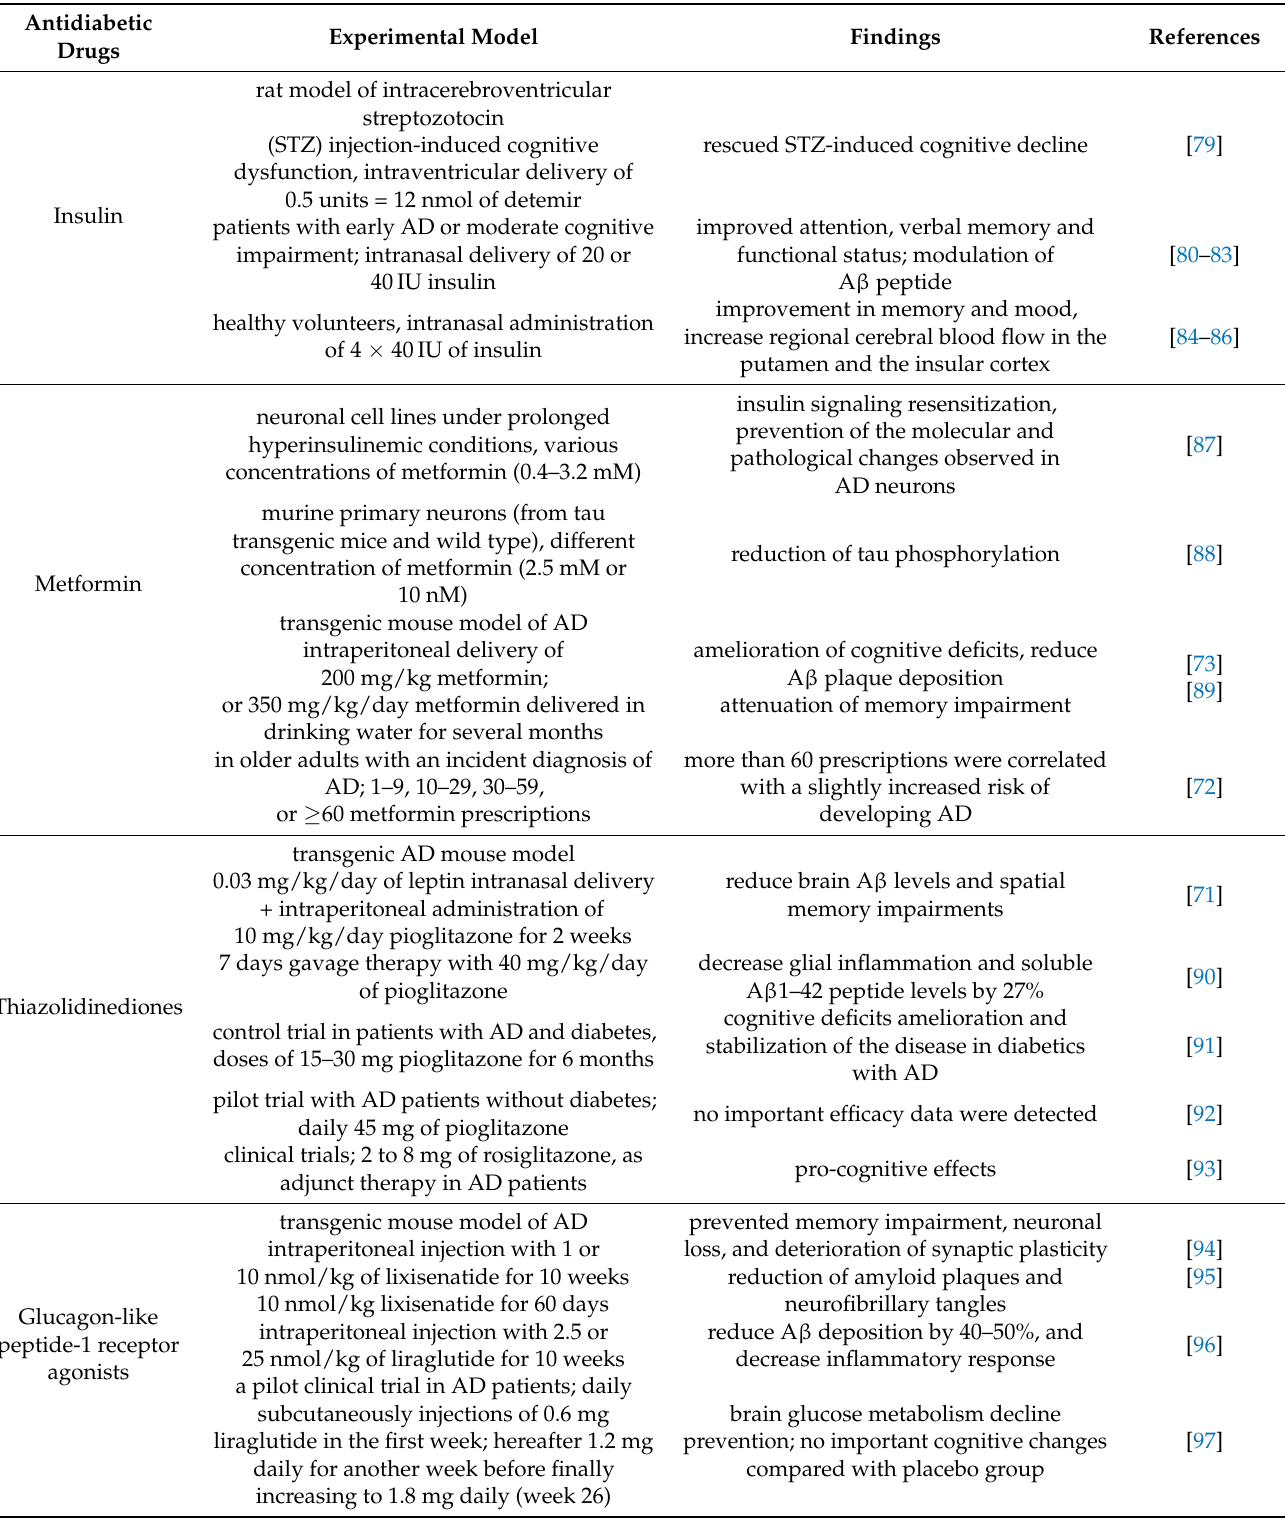
Table 1. Classes of antidiabetic compounds as potential therapies for Alzheimer’s disease.